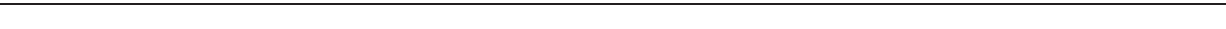
Fig. 2 Univariate analysis of the left HC long axis ROIs. a Depiction of the three hippocampal ROIs: aHC ( Y = − 4 to − 18) = light green, mHC ( Y = − 19 to − 29) = green, pHC ( Y = − 30 to − 40) = dark green. Visualizations of the anatomical masks are superimposed on a sagittal section of a template image. b FIR time courses over the fi rst 15 s (7TRs) for all picture types combined. Statistical comparisons were calculated for the peak response (average of the 5 s and 7.5 s time points). The activity in the 28 d group compared to the 1 d group decreased in the aHC (main effect Group: F (1,46) = 15.46, p = 0.0003, generalized η 2 = 0.1546, n = 48) and mHC ( F (1,46) = 9.24, p = 0.0038, generalized η 2 = 0.0999, n = 48). There was no difference between the groups